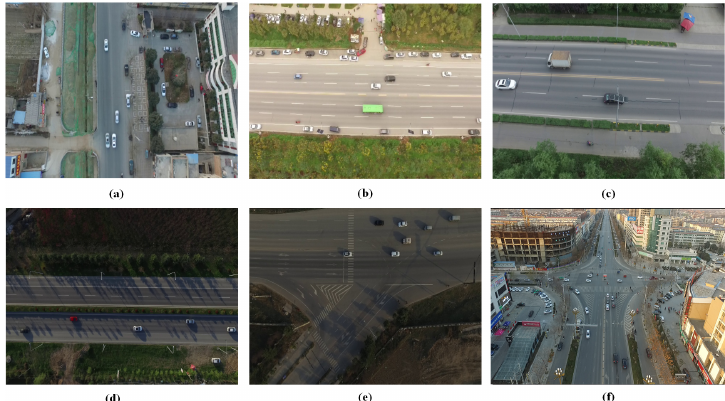
Figure 1. Aerial images captured from our Unmanned Aerial Vehicle (UAV) system, including a variety of complex scenes posing various challenges for target tracking: ( a ) adhesion occurring between two adjacent cars, ( b ) massive vehicles on side of the road, ( c ) complex background, ( d ) many tree shadows, ( e ) small target size and similar target appearance, ( f ) large changes in target size and complicated target